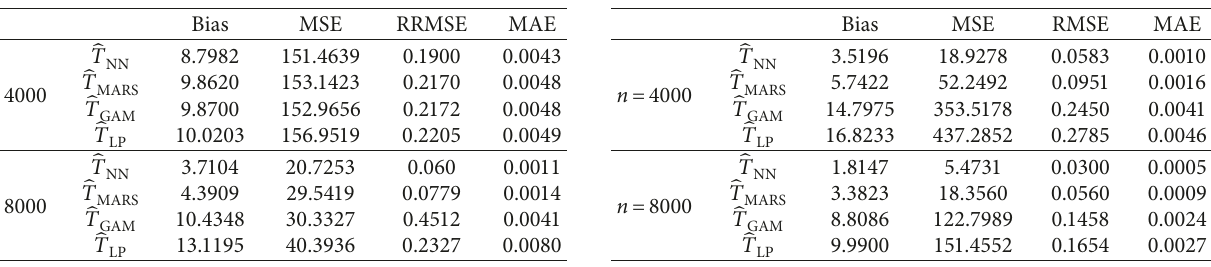
Table 1: UBIAS, UMSE, URMSE, and UMAE for a two-dimen- sional linear model.